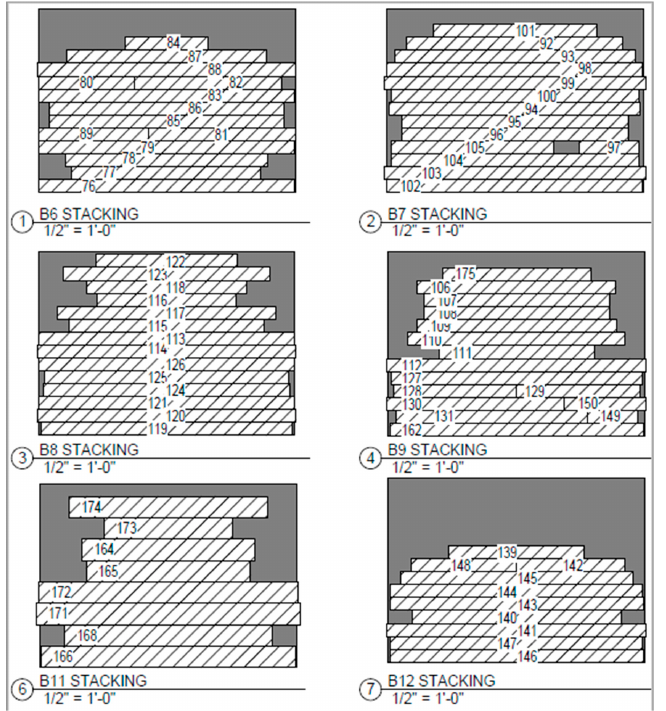
Figure 5. Example panel shop fabrication ticket.